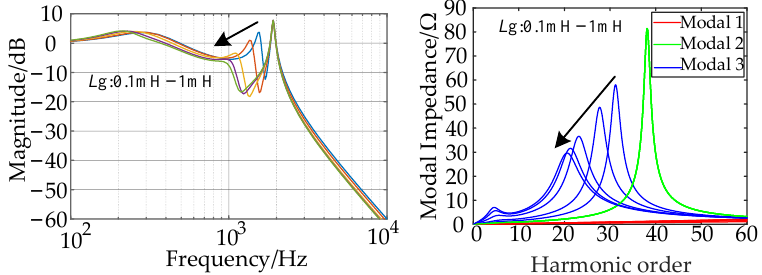
Figure 11. The resonance characteristic curve changes when L g is changed.